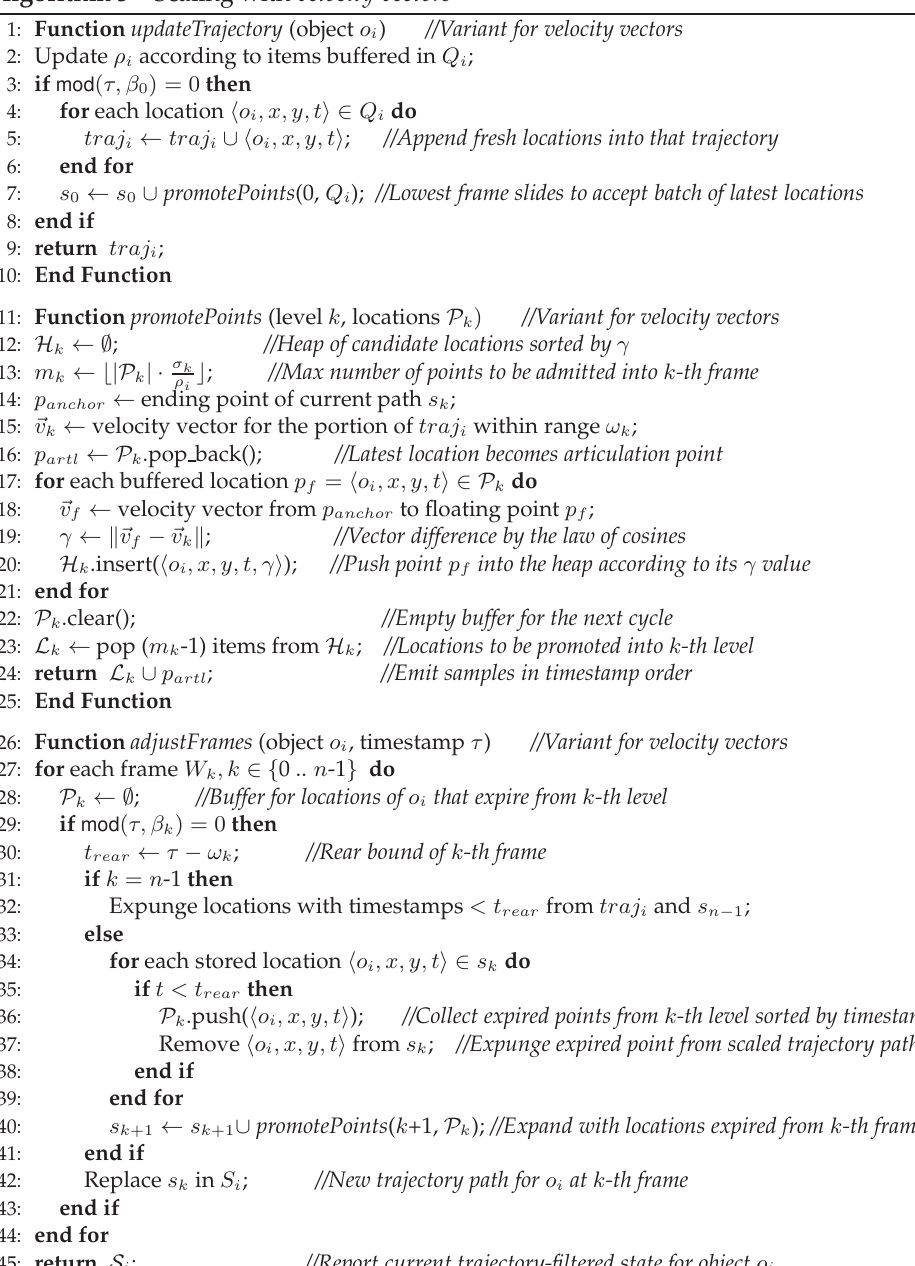
Algorithm 3 Scaling with velocity